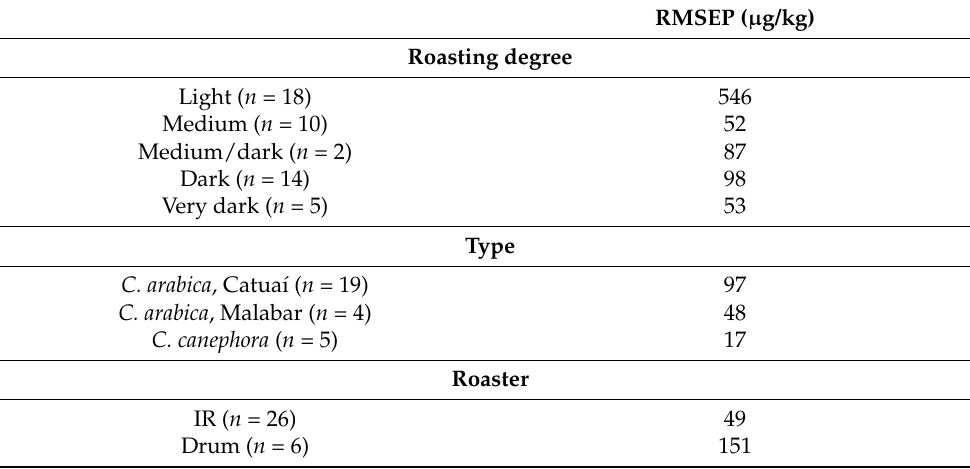
Table 2. RMSEP ( µ g/kg), grouped by roasting degree, type and